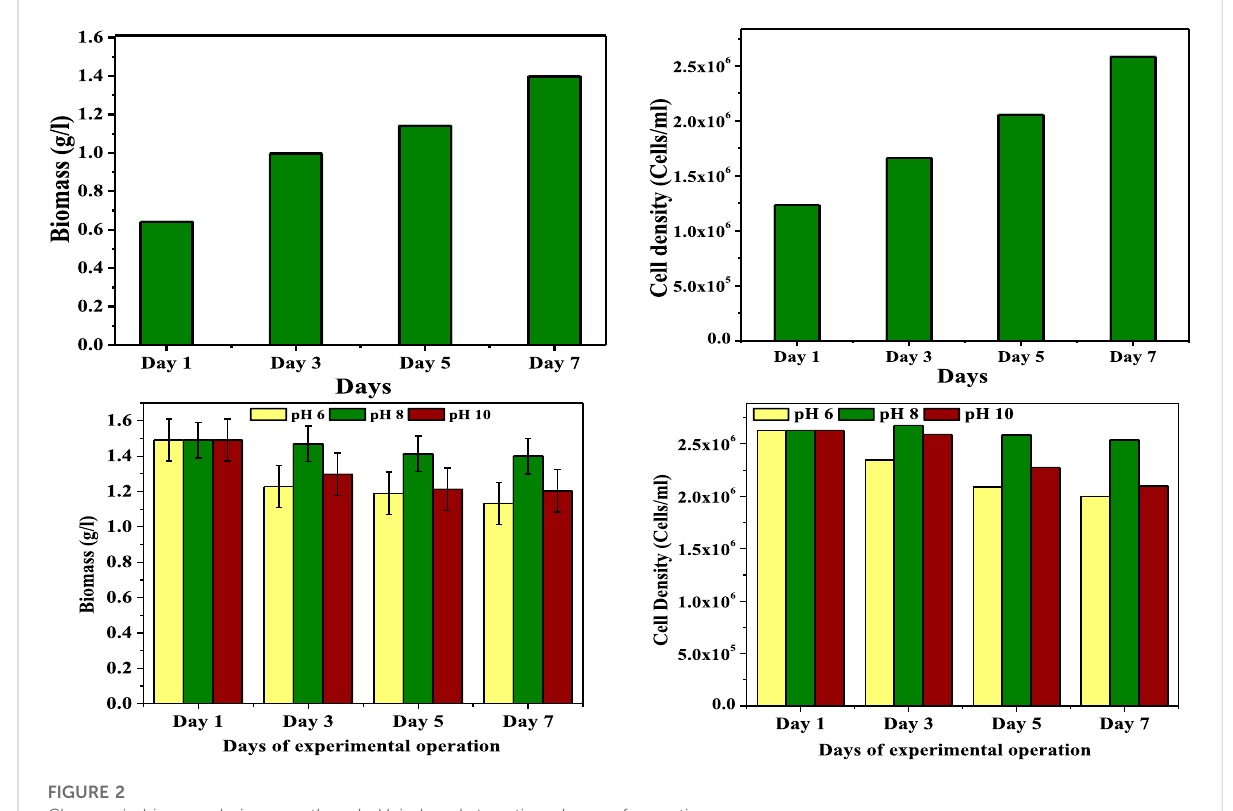
FIGURE 2 Changes in biomass during growth and pH-induced starvation phases of